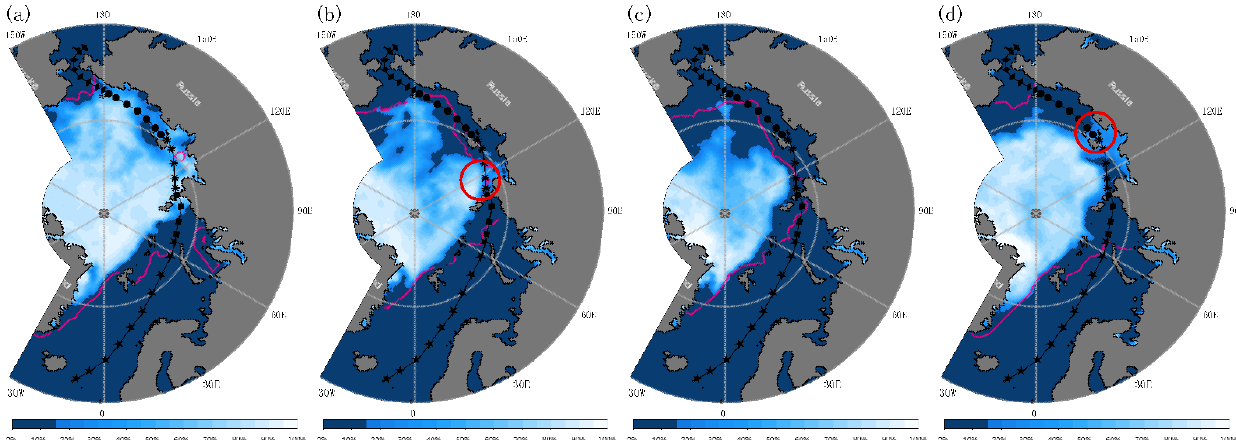
Figure 5. Spatial distribution map of sea ice concentration from July to October 2016 ( a – d ). (The red circles represent the special areas, the red line is the average sea ice edge line for each month from 1981 to 2010.).